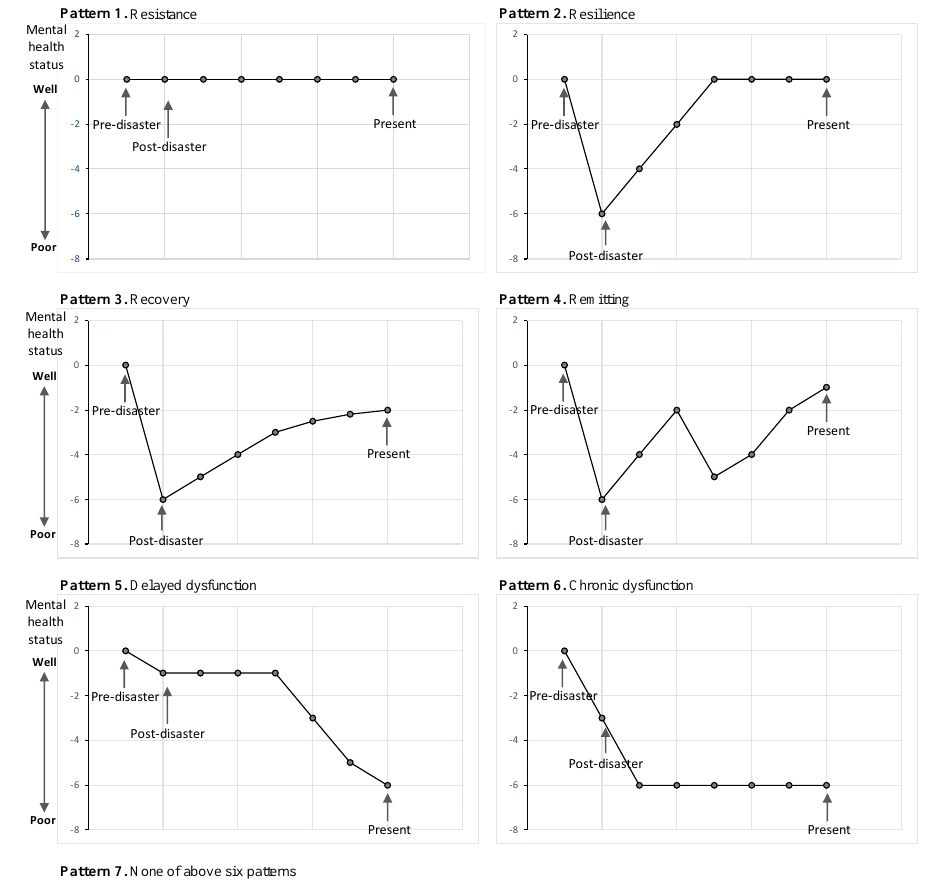
Figure 2. The mental health recovery patterns: the trajectory models of resilience, recovery, remitting, and delayed/chronic dysfunction presented by Norris et al. (2009) [31] was utilized as the measurement scale for our questionnaire. Participants were asked the subjective question of which of the seven patterns most appropriately described their mental health status changes from pre-disaster to its current state and they selected the most appropriate choice from six mental health recovery patterns.